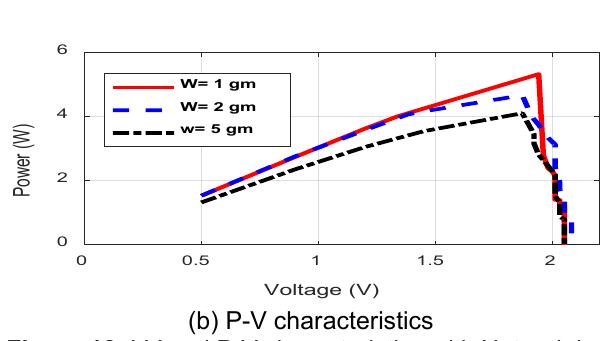
Figure 12. I-V and P-V characteristics with Natural dust at 300W/m 2 Above I-V and P-V curves are used to calculate the FF, maximum power and other electrical parameters of the PV module, depicted in Table 5 as, Table 5. Comparison of parameters with natural dust at 500/300 W/m